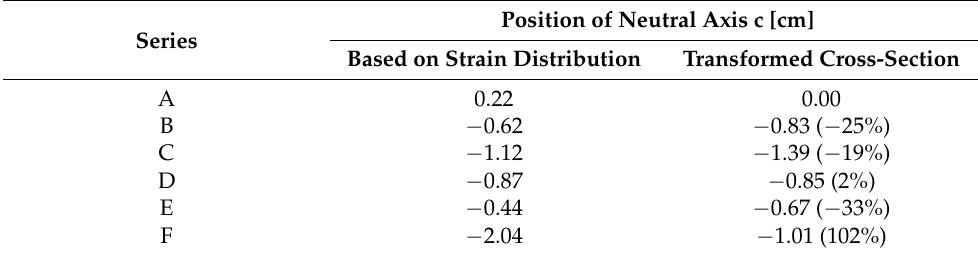
Figure 11. Characteristic phases of neutral axis position changes during bending tests. Table 2. Average values of offset of neutral axis from geometric centroid of beam at failure. Position of Neutral Axis c [cm] Series Based on Strain Distribution Transformed Cross-Section